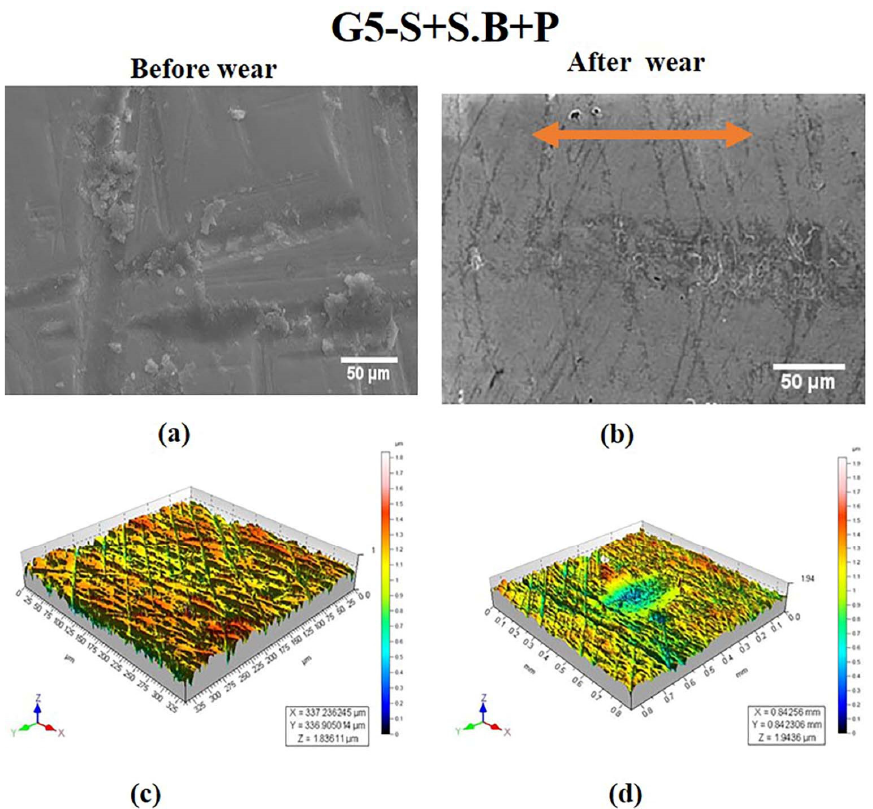
Figure 6. SEM images of specimen in G5 group at magnifications of 50 µ m ( a ) before wear and ( b ) after wear. 3-D surface morphology profile ( c ) before wear ( d ) after wear. Wear track is indicated by arrow.